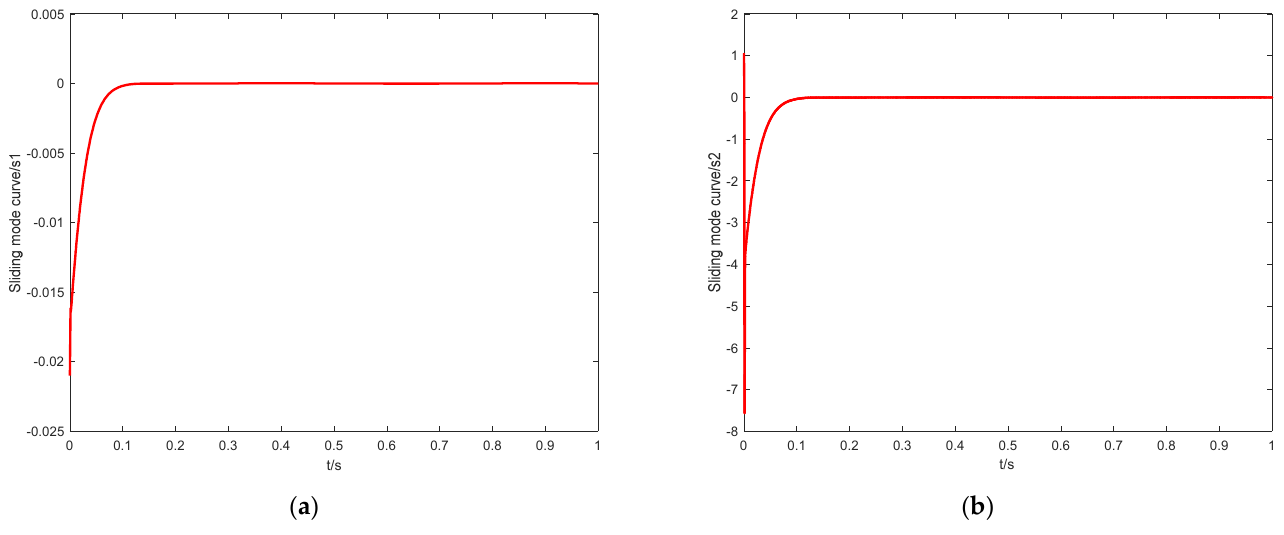
s s Figure 14. Sliding mode change curve. ( a ) T he change curve of 1 ; ( b ) T he change curve of 2 . Figure 14. Sliding mode change curve. ( a ) The change curve of s 1 ; ( b ) The change curve of s 2 . Similar with simulation case 1, Figures 10–14 show that the FGFTSMC strategy still Figure 14. Sliding mode change curve. ( a ) T he change curve of 1 s ; ( b ) T he change curve of 2 s . Similar with simulation case 1, Figure 10, Figure 11, Figure 12, Figure 13 and Figure has good control performance after considering unknown parameters and interference of 14 show that the FGFTSMC strategy still has good control performance after considering the system, which shows that the control algorithm has excellent